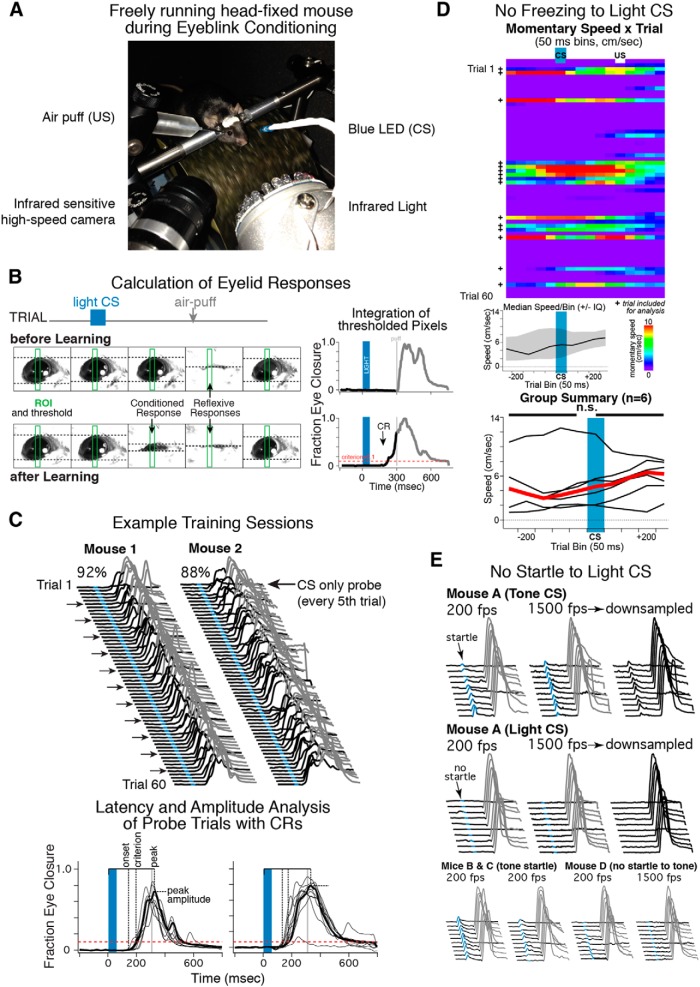
Apparatus and equipment configuration used for trace eyeblink conditioning in head-fixed mice (A), analysis of high-speed video (B), and example behavioral sessions from two mice (C). Mice did not show freezing (D) or startle responses (E) to presentation of a blue light CS. A, Mice were surgically implanted with a headplate to allow for fixation on a running wheel during training. CS included a blue LED CS and an air puff US. Eyelid behavior was monitored during trials with an infrared sensitive high-speed camera (200–250 fps). The black fur around the eye was illuminated with infrared light to contrast with a mouse’s eye and allow for analysis (see below). B, Standard trace conditioning trials consisted of a 200 ms baseline, 50 ms blue light CS, and a 250 ms stimulus-free trace interval followed by a 20 ms air puff US (top). Each frame of a trial was analyzed by calculating the ratio of white–black pixels within a specified region of interest (green rectangle in example sample frames; dashed lines show borders of white and black thresholded pixels), yielding the FEC at each sampled time point during a trial (right graphs; upward deflection indicates closure, red dashed line shows the minimum FEC to qualify as a CR, 0.1). Initially the mouse closed his eye only in response to the air puff (top), but with continued training learned to close his eye in response to the light CS and in anticipation of the air puff (bottom, CR). C, Waterfall plots show each trial of a session from two well trained mice (blue indicates presentation of light CS, gray indicates presentation of air puff US). Training sessions consisted of 60 trials, with CS-only probe trials presented every fifth trial (arrows) to allow for analysis of CRs in the absence of reflexive US responses. Note the upward deflection of the black lines prior to the air puff presentation for many of the trials, indicative of a CR. Bottom graphs show probe trials from the example sessions, which were used to calculate the latencies and amplitude of CRs for each mouse/session (see text). Note the absence of apparent startle responses just after CS presentation and the ramping topography of eyelid closures such that the peaks of CRs were well timed to US presentation (which were not presented during probe trials). D, Example wheel-running behavior from one mouse during its first trace eyeblink conditioning session (pseudocolor plot, each row is one trial, “+” indicates trials in which mouse was running before CS onset and included in analysis), and the averaged momentary speed before and after CS presentation (middle graph, median ± IQR). Bottom graph shows the averaged momentary speed for six mice (black lines), indicating that mice did not decrease locomotion (freeze) in response to the light CS (paired t = −1.31, df = 5, p = 0.25, n.s.). E. Example eyelid responses from four mice subjected to a startle-eliciting tone (top and bottom rows) or blue light CS (middle row), sampling at either 200 or 1500 fps as indicated. Startle responses to the tone were clearly detected when sampling at 200 fps, and were never observed in response to the light CS, even when sampling at 1500 fps.